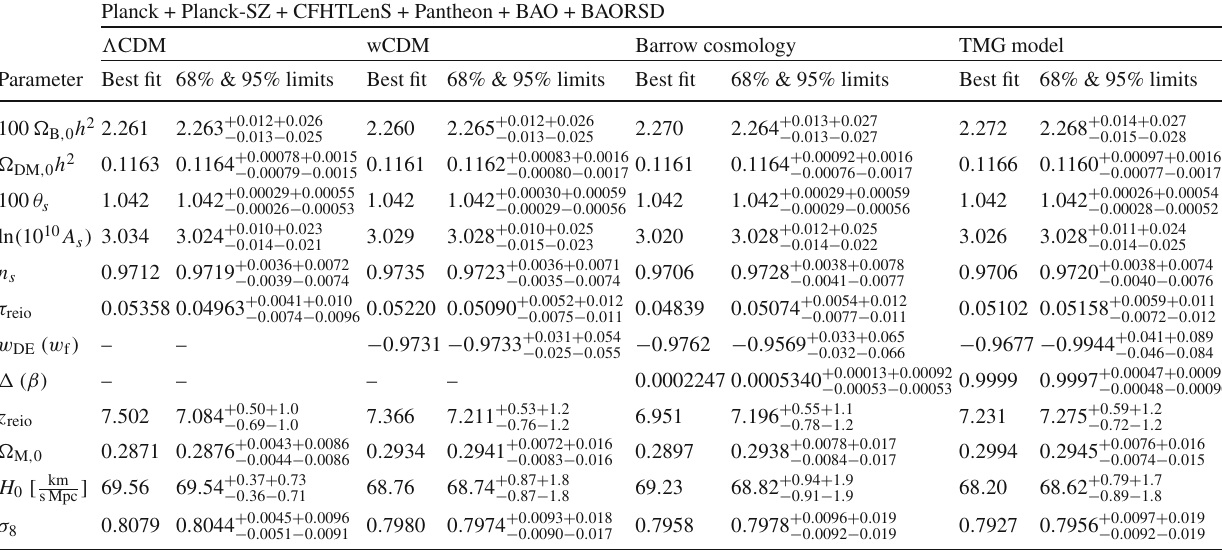
Table 2 Best-fit values and 68% and 95% confidence level intervals for the cosmological parameters of (cid:3) CDM, wCDM, Barrow cosmology (with Barrow parameter (cid:2) ), and also the TMG model (with Tsallis parameter β ) from Ref. [76], considering dataset (II) Planck + Planck-SZ + CFHTLenS + Pantheon + BAO +